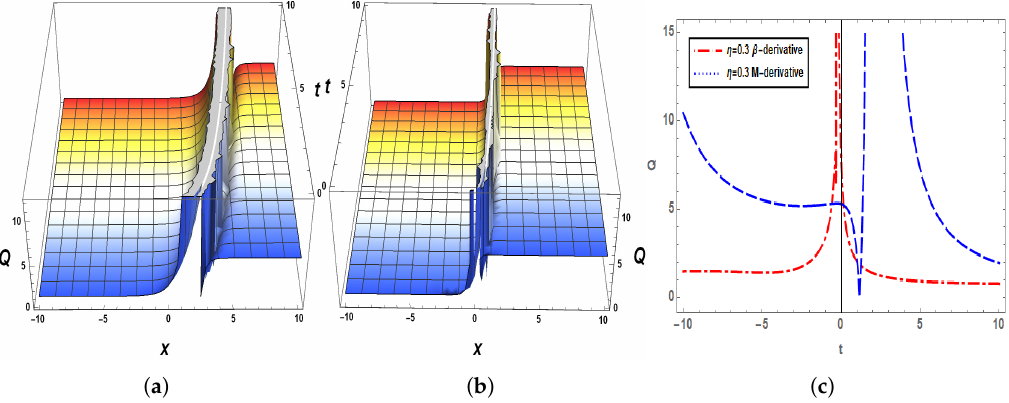
Figure 6. For Q 8,2 ( x , t ) , now take µ = 0.5, γ = − 0.8, σ = 0, θ = 1, ϑ = 1, (cid:101) = 0.5, λ = 1 and C = − 1. Here, ( a – c ) represent 3 D and 2 D graphs with both operators letting η = 0.3.